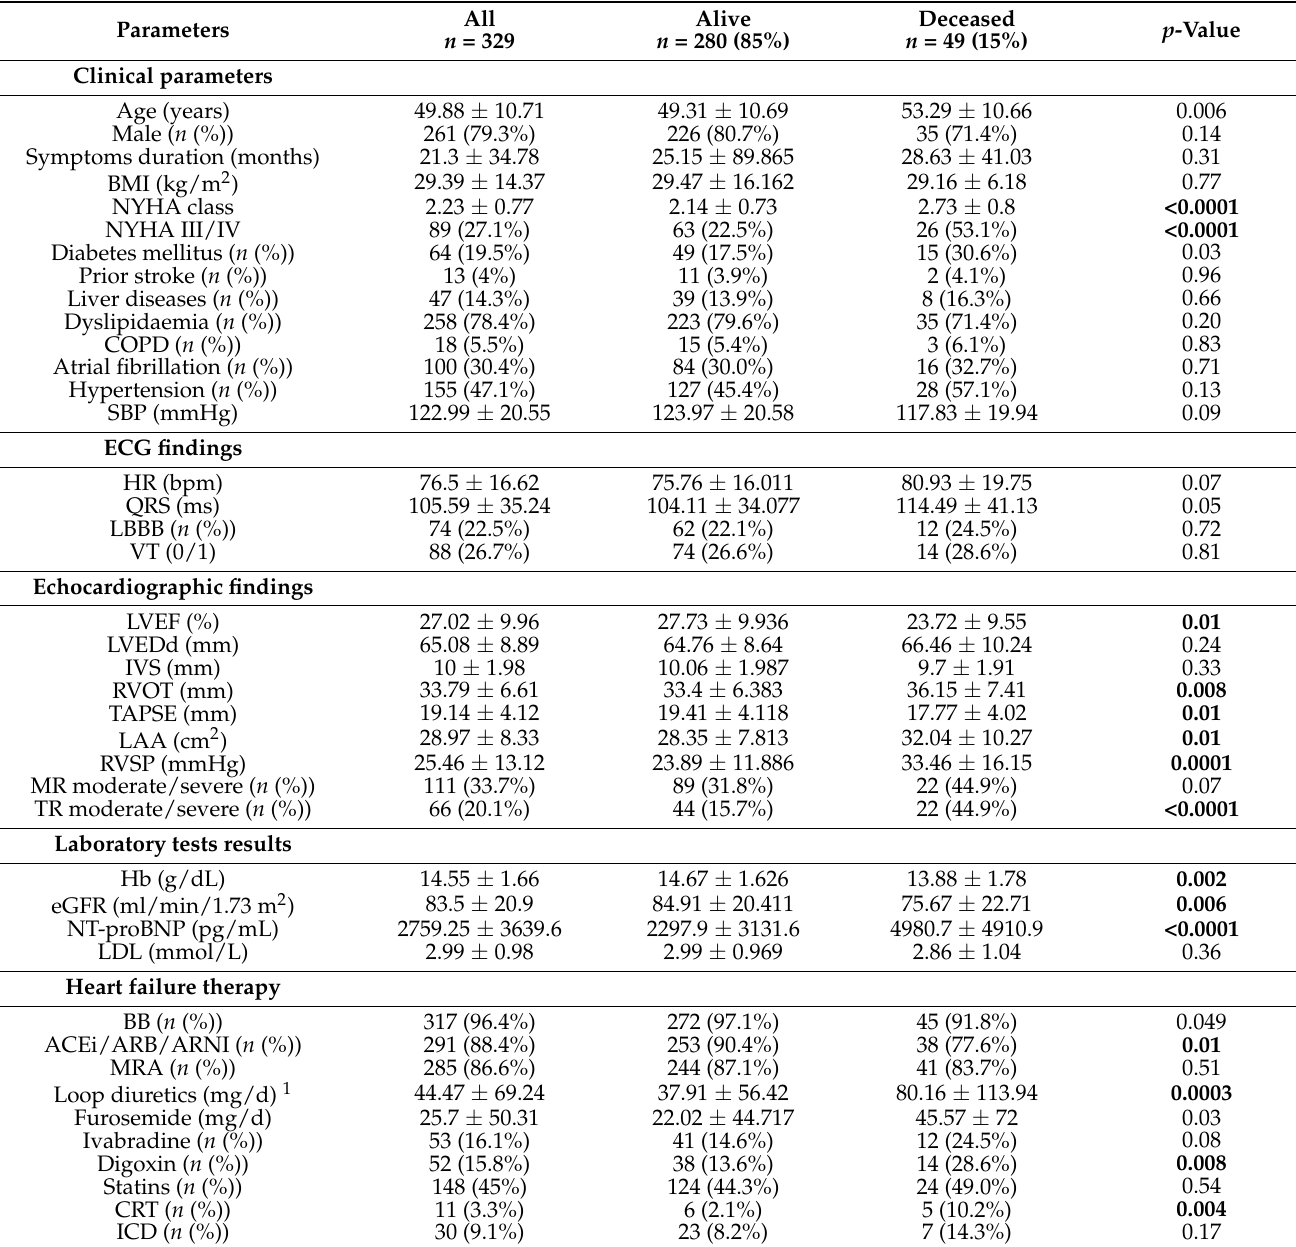
Table 1. Baseline